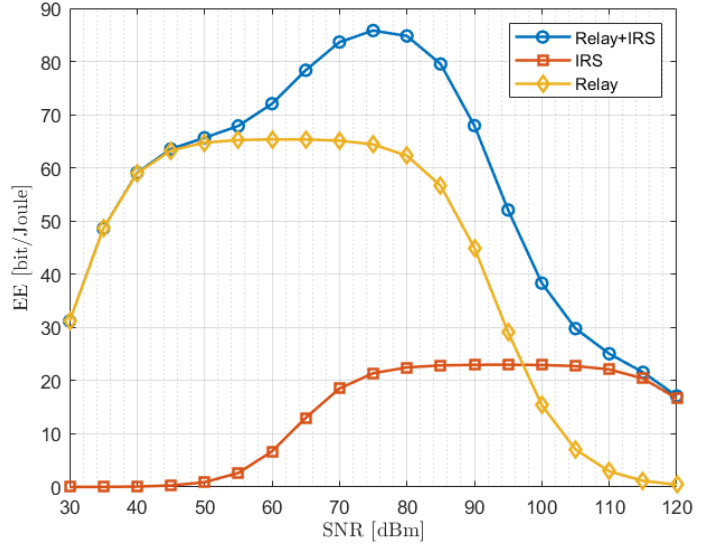
Figure 6. EE versus SNR with fixed N.